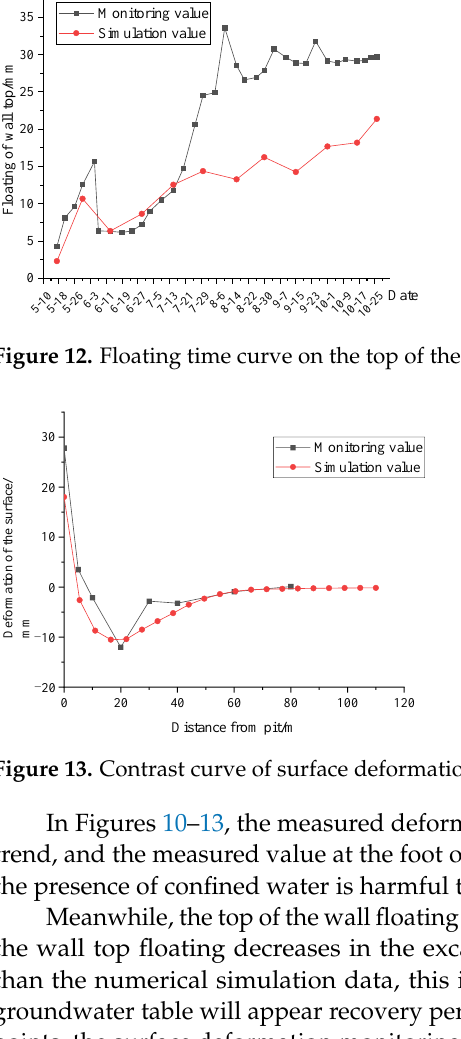
Figure 11. Horizontal deformation comparison diagram of ground wall.